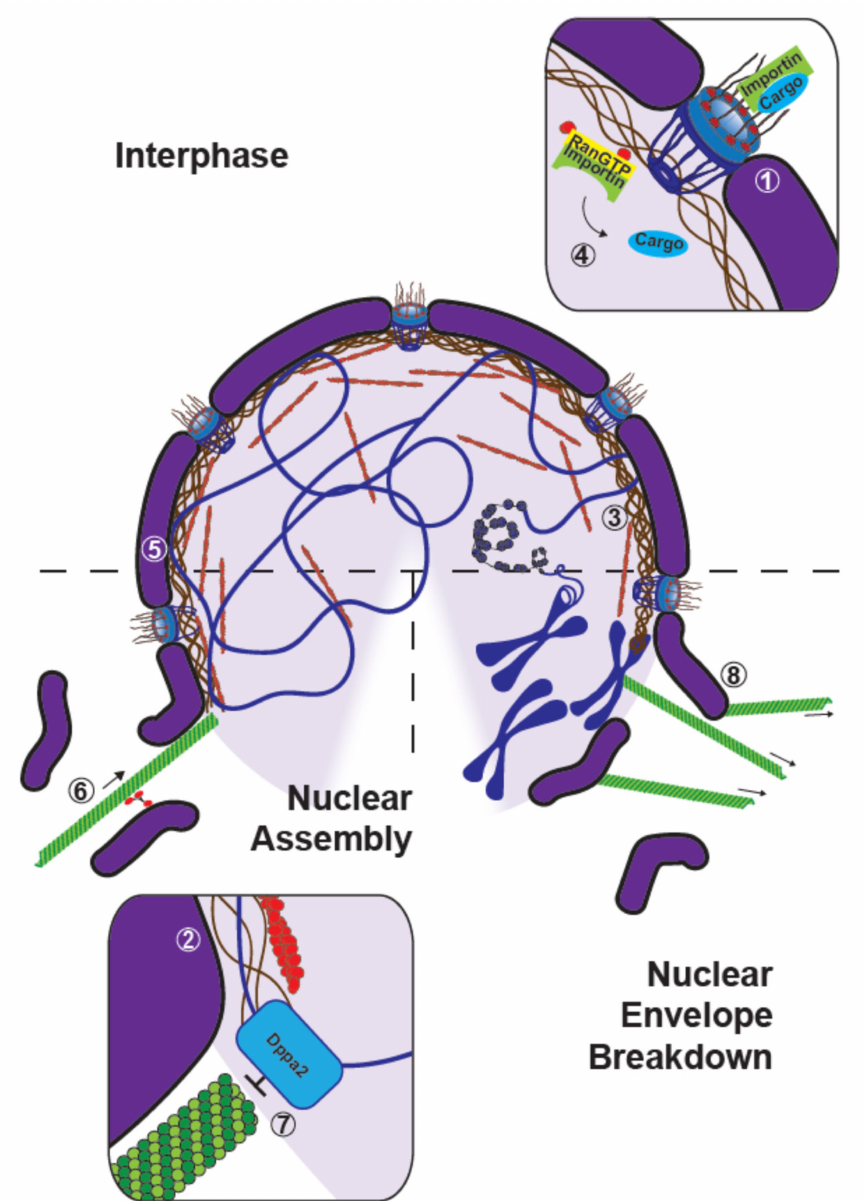
Figure 4. The cytoskeleton and nuclear assembly, structure, and breakdown. Overview schematics of the different contributions of the cytoskeleton to the formation and maintenance of the nucleus. Nuclear envelope is shown in purple, chromatin in blue, lamin filaments in brown, actin in red and microtubules in green. ( 1 ) Lamin B3 promotes the recruitment of the nucleoporin, Nup153, into nuclear pores and to the nuclear envelope. ( 2 ) The Lamina-associated protein LAP2 contributes to DNA-nuclear membrane interactions, and ultimately to the elongation of DNA during replication. ( 3 ) F-actin accumulates at the sub-nuclear membranous region to stiffen the nuclear lamina and maintain the binding of chromatin to the nuclear envelope. ( 4 ) Nuclear actin helps the release of cargoes from RanGTP-importins. ( 5 ) The actin-interacting protein, protein 4.1, relies on its spectrin- actin-binding domain (SABD) to interact with nuclear actin and contribute to the nuclear formation. ( 6 ) Minus-end directed motors transport membranous nuclear envelope precursors to assemble the nucleus. ( 7 ) The chromatin binding protein, Dppa2, inhibits microtubule polymerization near chromatin to allow for proper nuclear assembly. ( 8 ) Microtubules may serve a role in removing membranes during nuclear envelope